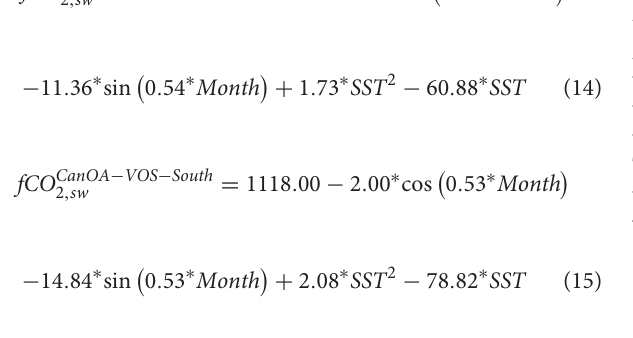
The seasonal change of f CO 2 , sw with SST obtained through the northern and southern sections of the CanOA-VOS line is given by Eqs 14, 15 ( r 2 = 0.78 and r 2 = 0.66, respectively) with a standard error of estimate of ± 10.3 and ± 8.9 µ atm,